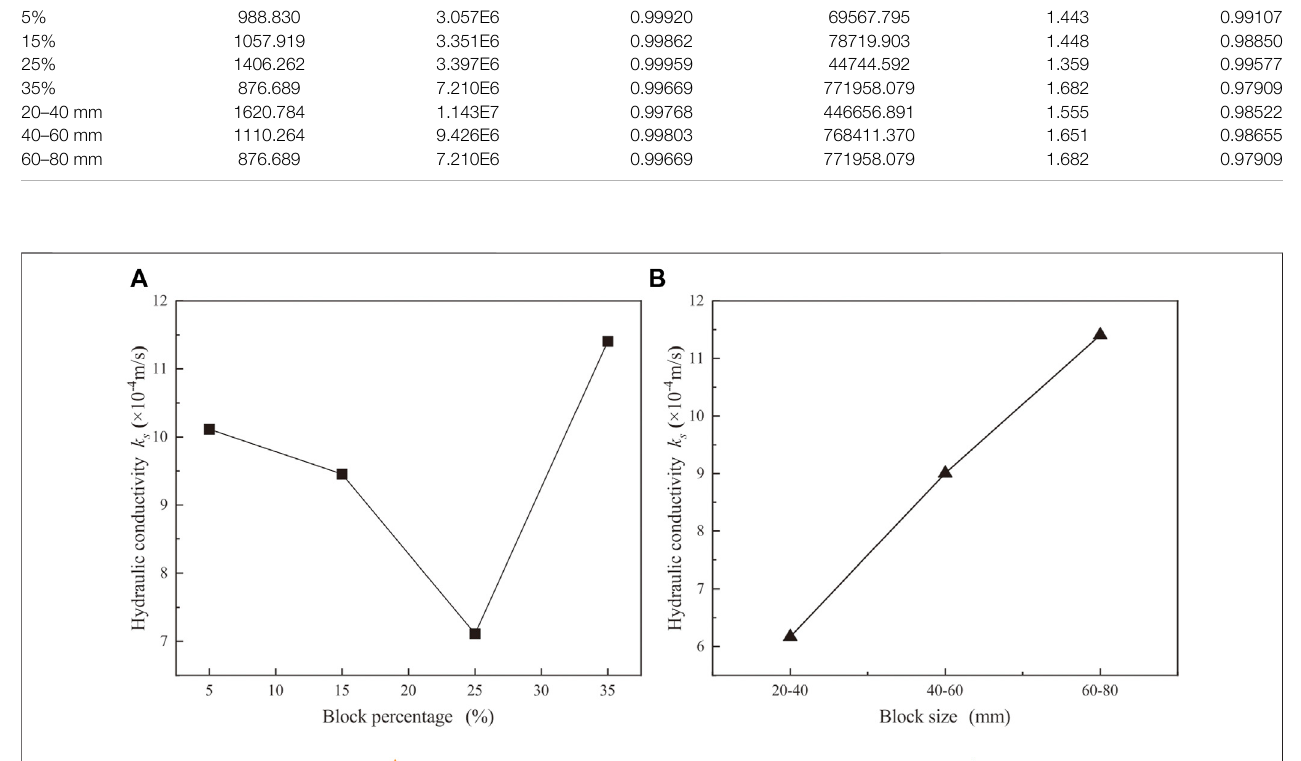
Frontiers in Earth Science |